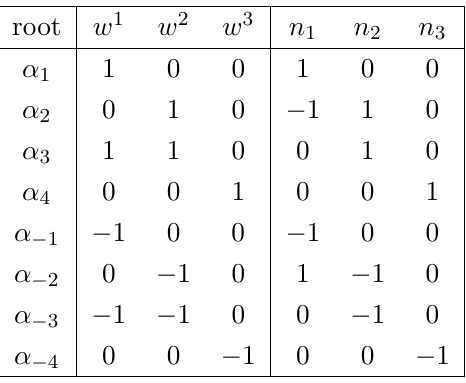
Table 9 . Momentum and winding numbers of the massless vectors at the SU(4) L (cid:2) SU(4) R en- hancement point of T 3 .